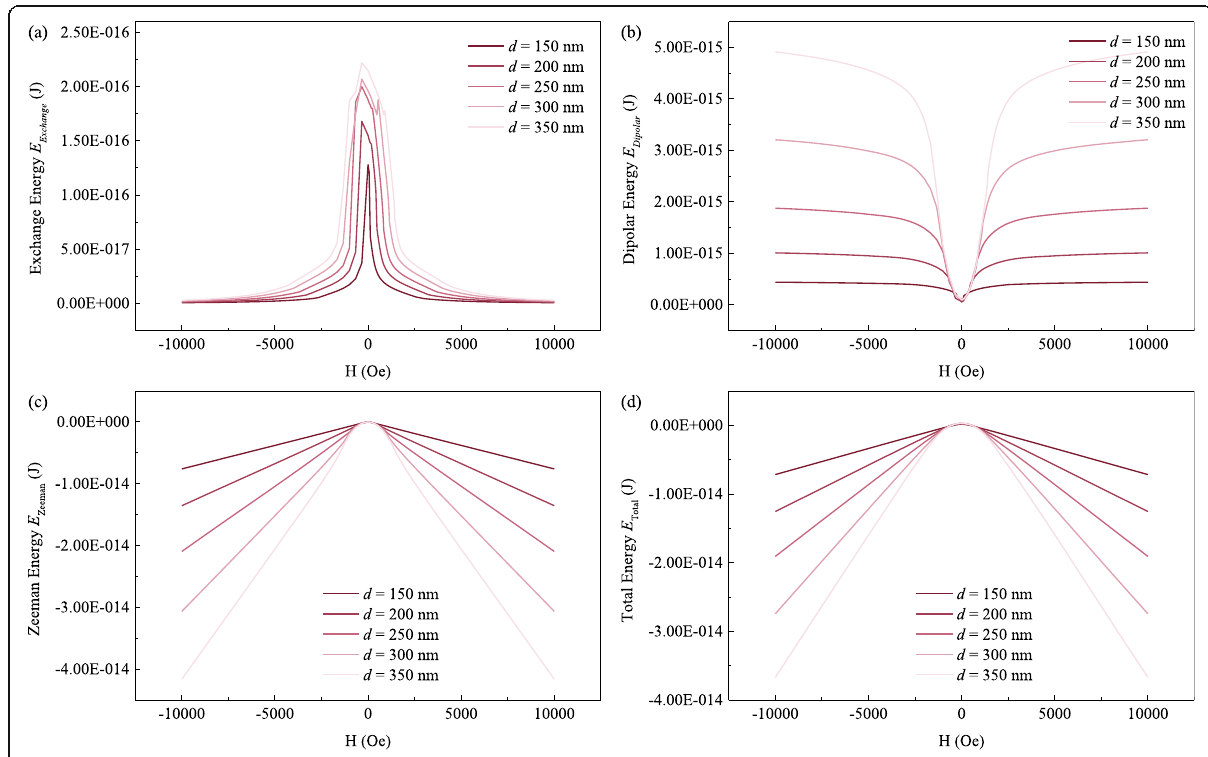
Fig. 3 The plot of ( a ) exchange energy, ( b ) dipolar energy, ( c ) Zeeman energy, and ( d ) total energy against applied magnetic field